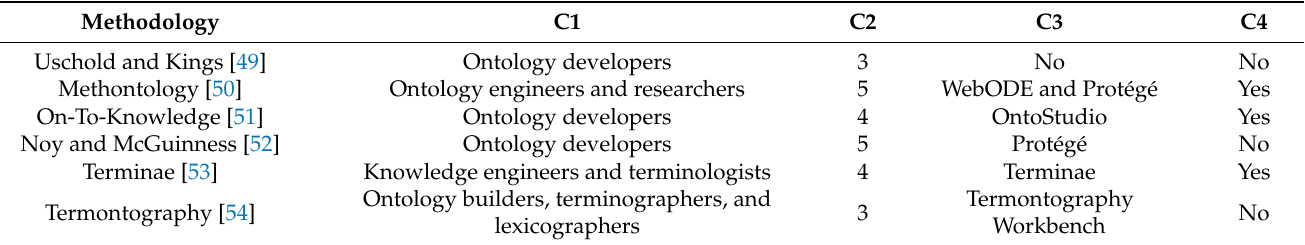
Table 2. Comparison of methodologies to build ontologies; source: